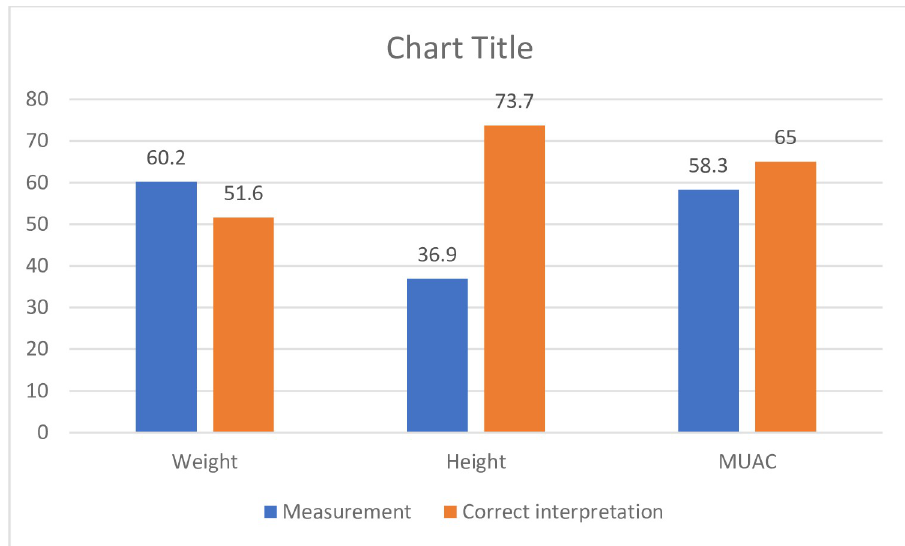
Fig 1. Proportion of children receiving anthropometric measurement during IMNCI service